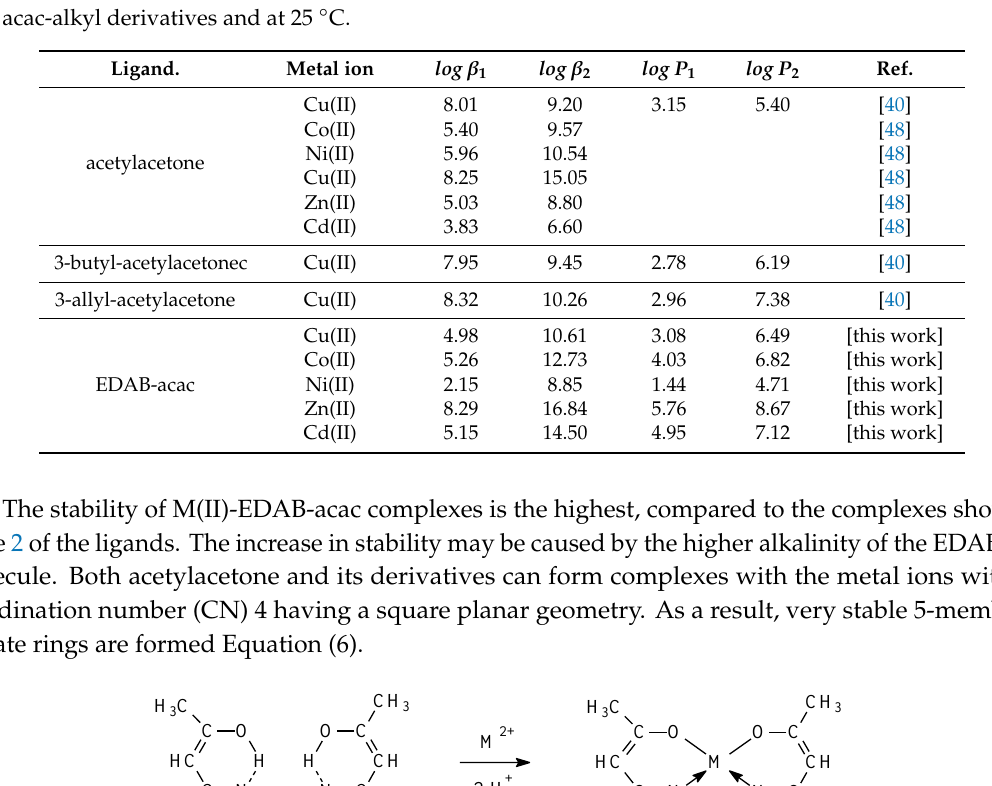
Table 2. Comparison of the stability constants β n of M(II) complexes with EDBA-acac, acac, and acac- alkyl derivatives and at 25